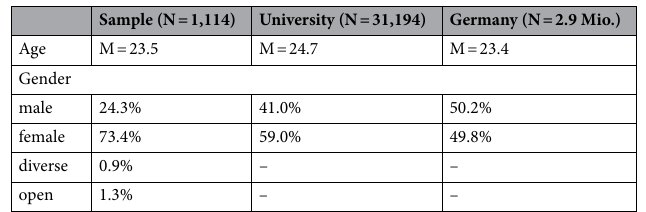
Table 1. Distribution of age and gender of all participants in the final sample, among students at the corresponding university, and in the student body in